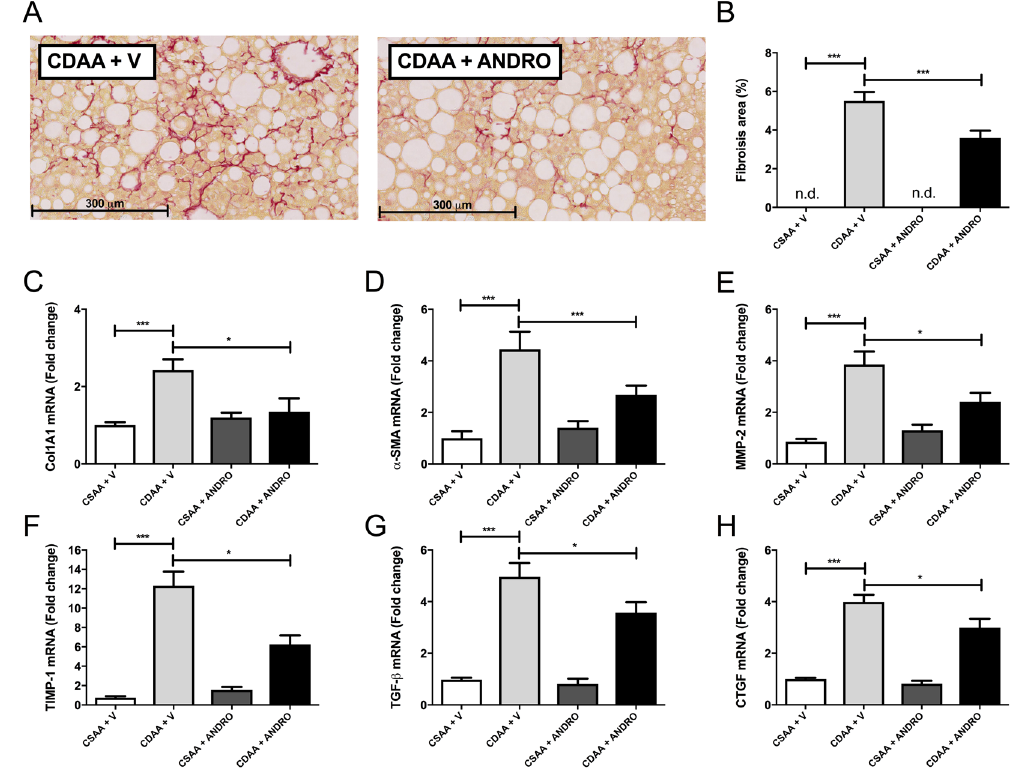
Figure 2. Andrographolide(ANDRO)-treated mice are protected from CDAA-induced liver fibrosis. ( A ) Liver sections Sirius Red staining from mice fed with choline-deficient amino acid-defined (CDAA) or choline-supplemented L-amino acid defined (CSAA) diets during 22 weeks and treated with ANDRO or Vehicle (V) as described in material and methods. ( B ) Fibrosis area was quantified using digital image analysis of the red-stained area in Sirius red-stained samples (NIH, Bethesda, MD, USA) and mRNA levels of Collagen, type I, alpha 1 ( C ), Alpha-smooth muscle actin ( α -SMA) ( D ), matrix metalloproteinase-2 (MMP-2) ( E ), Tissue inhibitor of metalloproteinase-1 (TIMP-1) ( F ), transforming growth factor beta TGF- β , ( G ) and Connective tissue growth factor precursor (CTGF) ( H ) assessed by real time-PCR. Statistical significance was evaluated using ANOVA with a post-hoc Bonferroni multiple-comparison test ( * p ≤ 0.05 and *** p ≤ 0.001. n.d = not